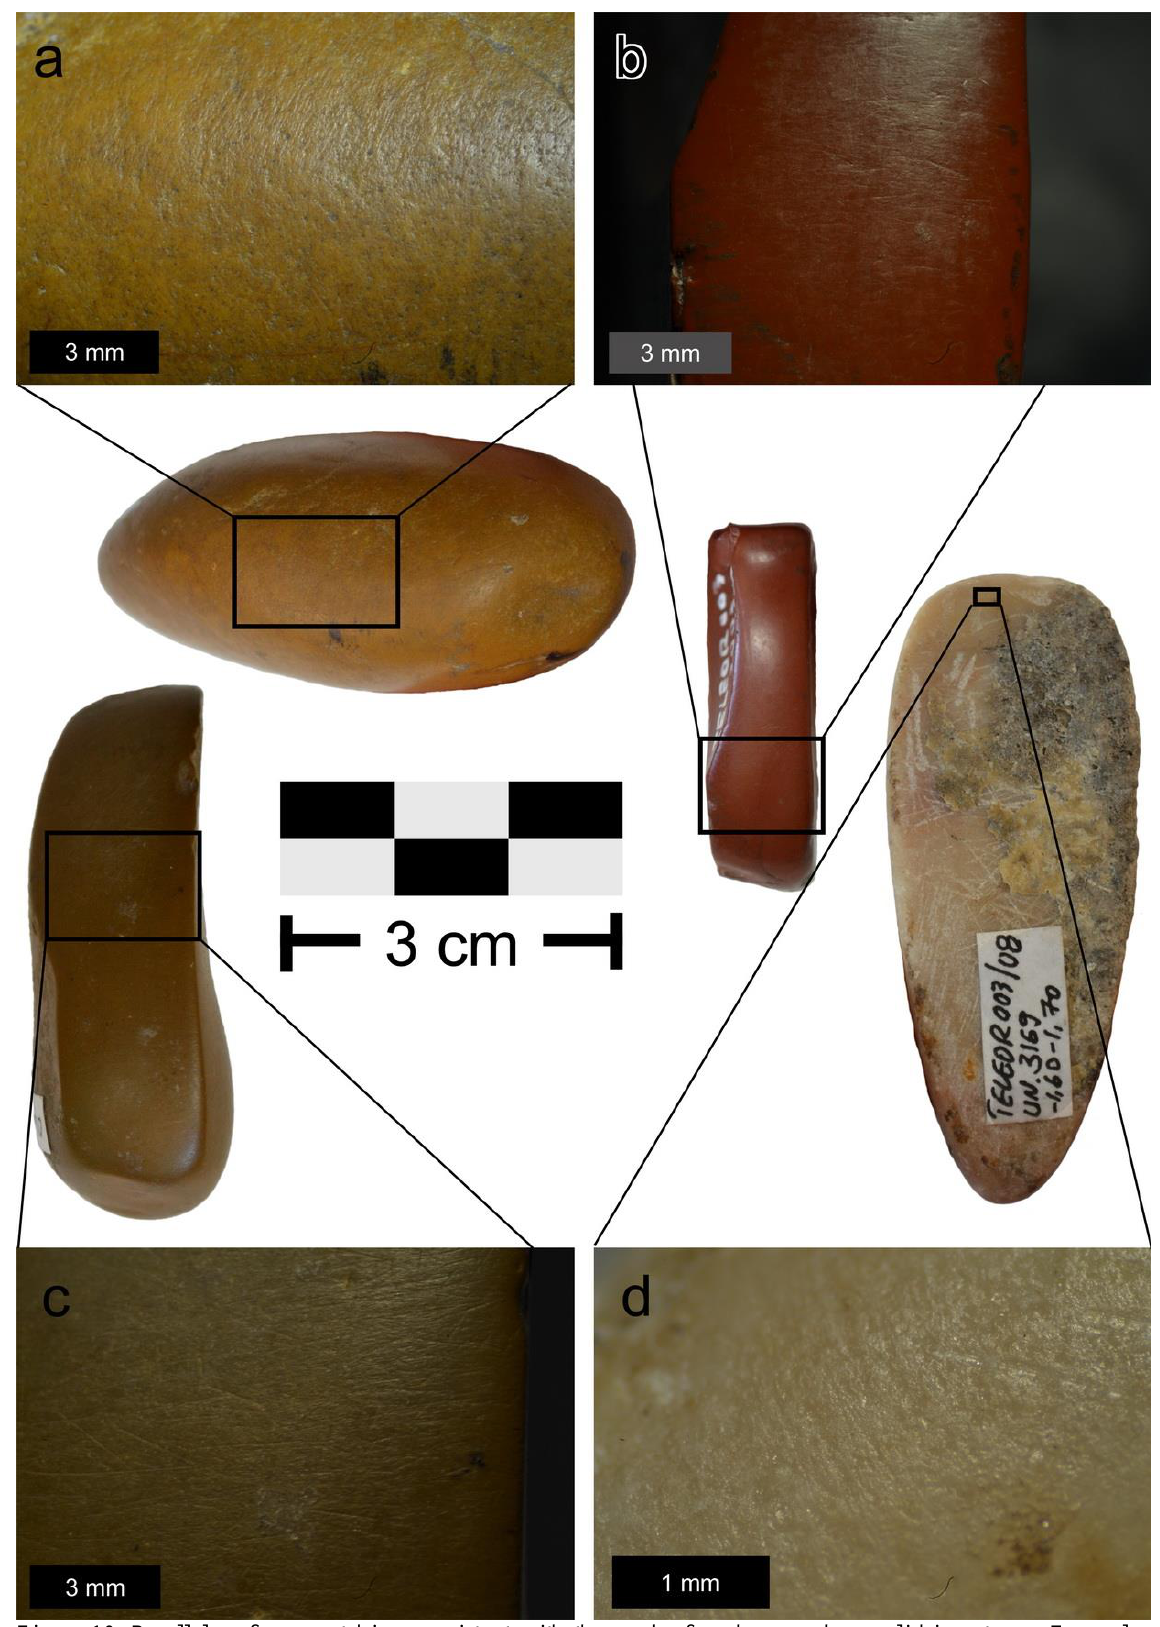
Figure 10. Parallel surface scratching consistent with the marks found on modern polishing stones. Examples from Măgura